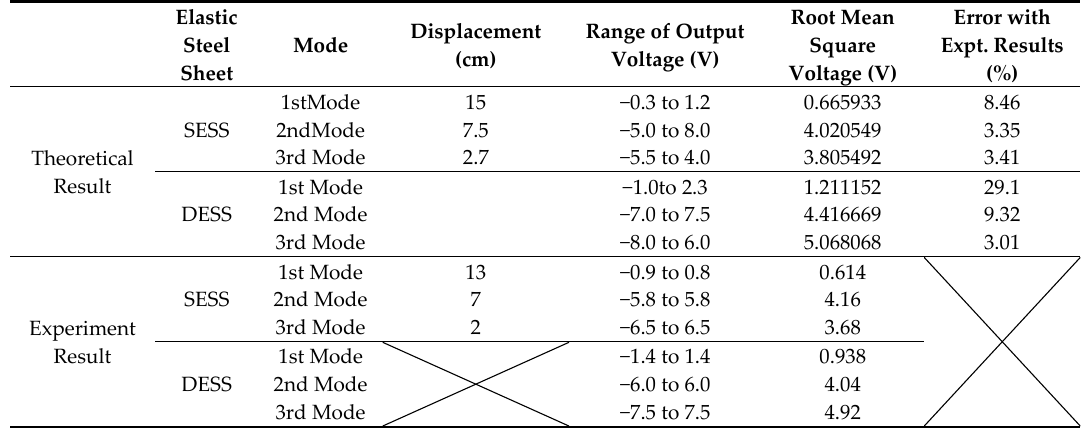
Table 6. Theoretical and experimental resultants of power benefits of SESS and DESS systems.